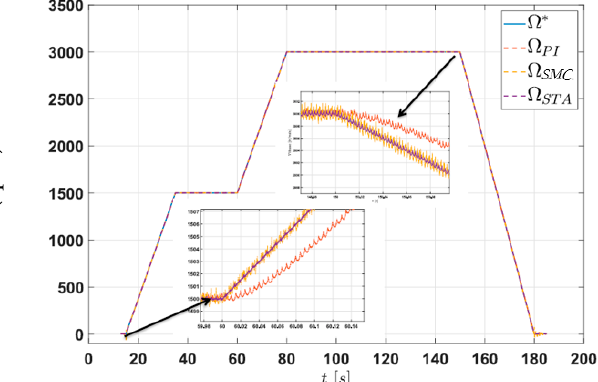
Figure 13. Velocity responses of the implemented robust controllers.